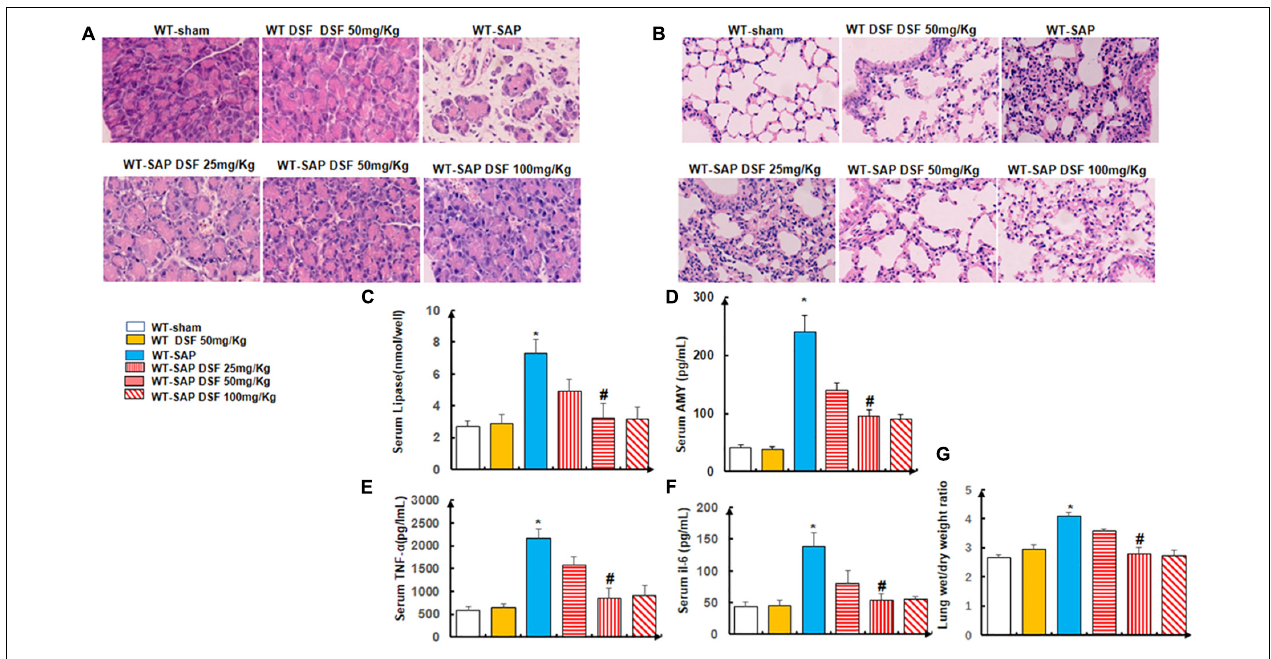
FIGURE 4 | Inhibition of pyroptosis with DSF alleviates the inflammation of the pancreas and lung. WT mice were separately treated with DSF of 25, 50, and 100 mg/kg. At 24 h after LPS injection, all mice were sacrificed. (A,B) Representative H&E staining of pancreatic and lung tissue. Scale bars, × 200. (C–F) Levels of lipase, amylase, TNF- α , and IL-6 in the serum were tested using ELISA. Experiments were repeated three times. (G) Wet/dry ratio was measured in the lung tissue. Data are presented as mean ± SD ( n = 10 per group). *p < 0.05 vs. other groups; # p < 0.05 vs. WT-SAP group, WT-SAP DSF (25 mg/kg); # p > 0.05 vs. sham,